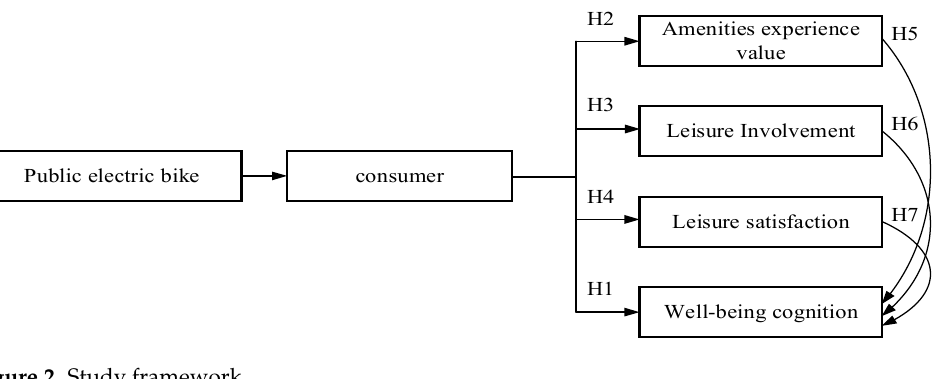
Figure 2. Study framework.